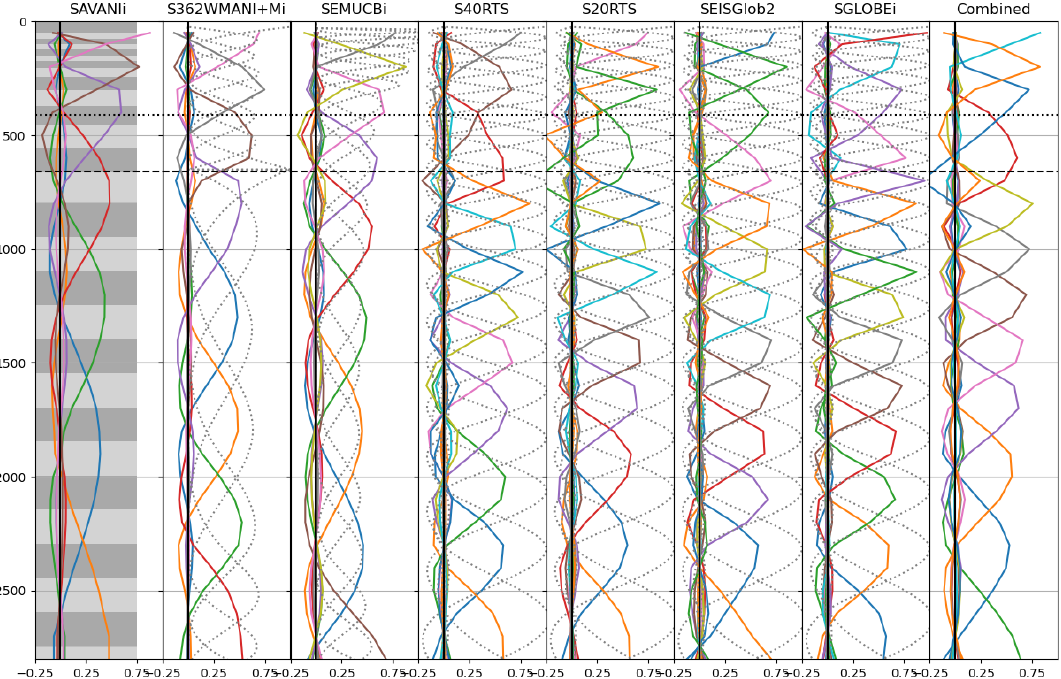
Figure 3. Principal components for the different individual model varimax PCAs and the combined one (see Sect. 6) for the isotropic part of the seven tomography models used in this study. Only the PC components above 1% are kept in this analysis (Fig. 2). The dashed grey lines represent the spline functions and the grey boxes the variable thickness depth layers used by the different models. The vertical dashed lines indicate the 410 and 660km seismic discontinuities.